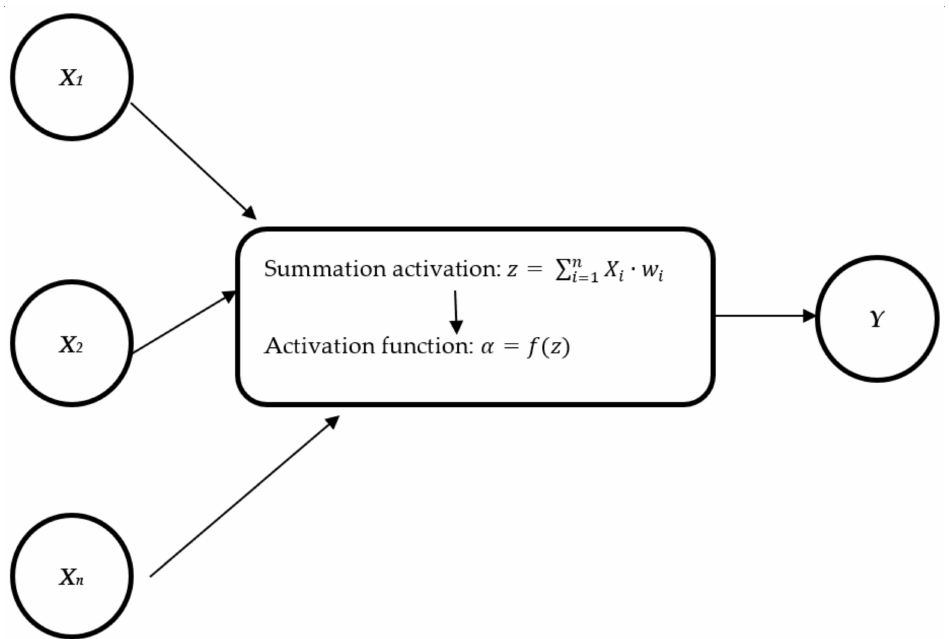
Figure 2. The basic Artificial Neural Network